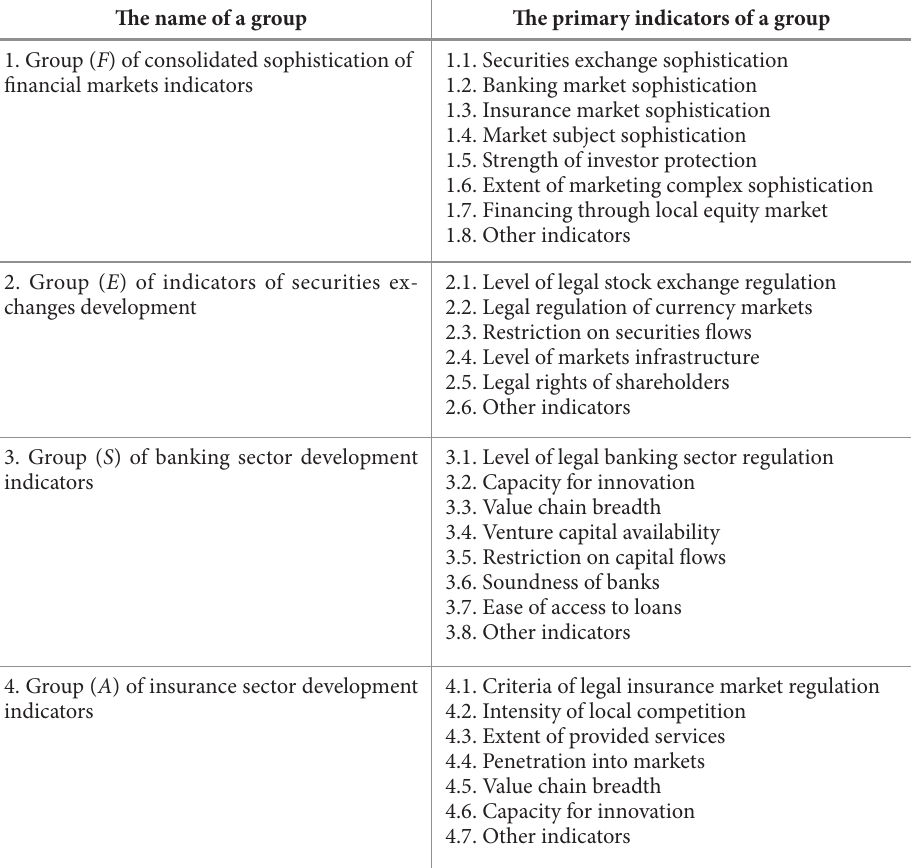
Table 1. The selected groups of the primary indicators (not ranked) The name of a